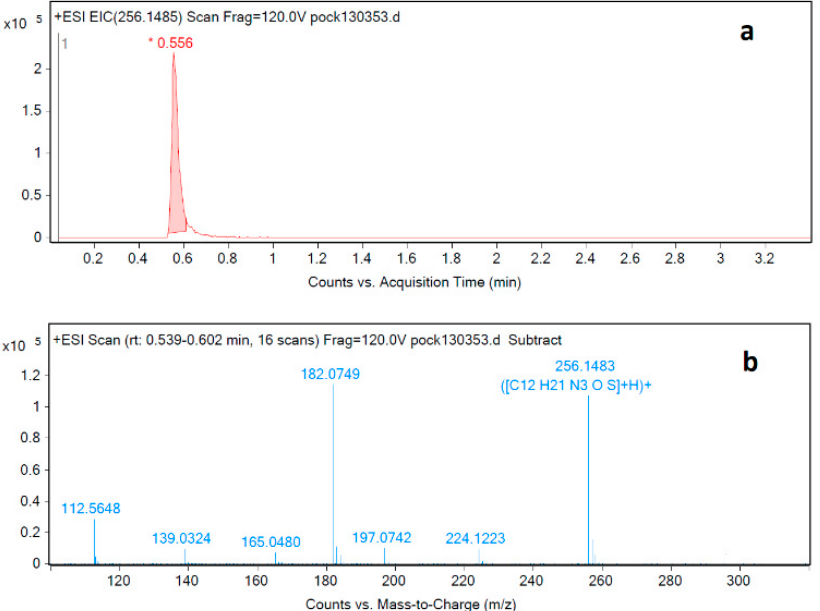
Figure 5. LC-MS-QTOF ( a ) chromatogram and ( b ) MS spectrum corresponding to injection of degradation impurity identification solution.